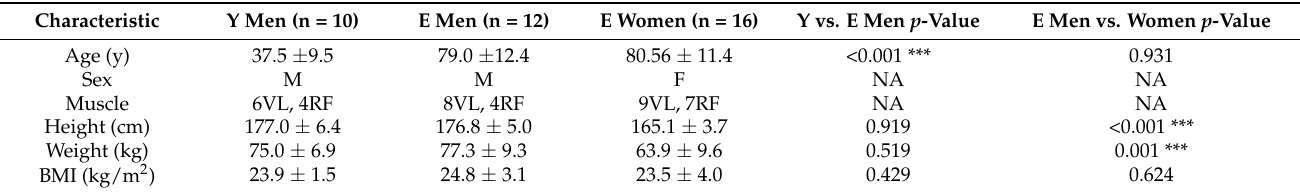
Table 1. Characteristics of the human participants (n =